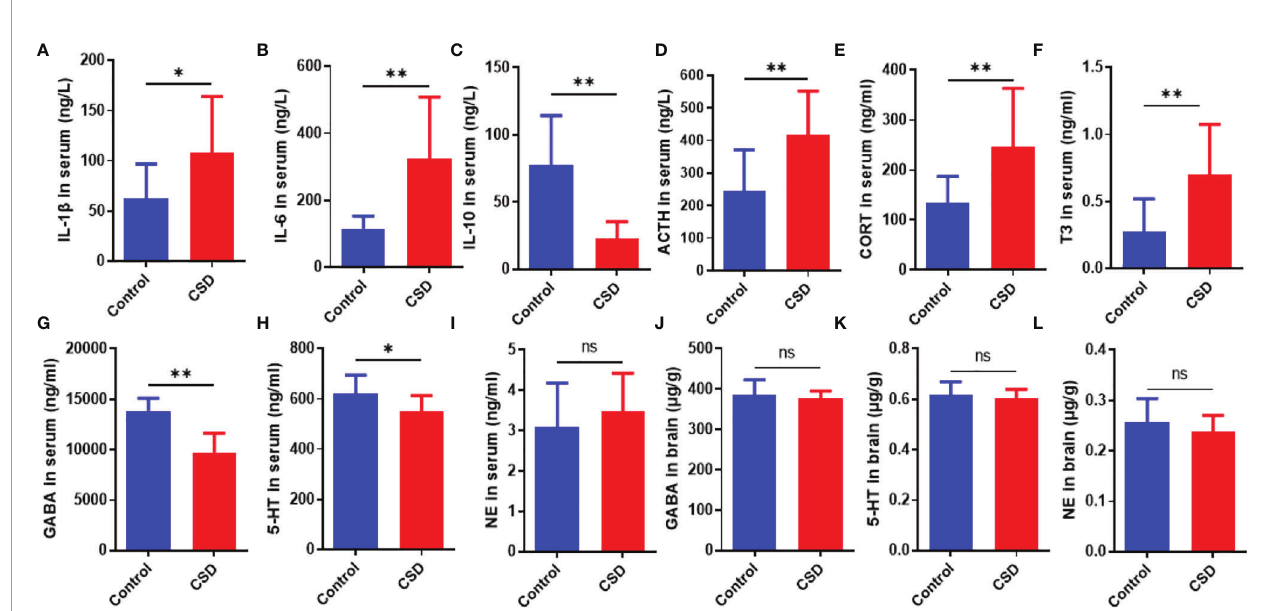
FIGURE 3 | The effects of CSD on the cytokine, neurotransmitter, and endocrine levels. Serum levels of (A) IL ‐ 1 b , (B) IL ‐ 6, (C) IL ‐ 10, (D) ACTH, (E) CORT, (F) T3, (G) GABA, (H) 5-HT, and (I) NE, and brain levels of (J) GABA, (K) 5-HT, and (L) NE (n = 12). Data are expressed as means ± SD. Statistical signi fi cance was analyzed by Student ’ s t test (ns, no signi fi cance; *P < 0.05; **P <